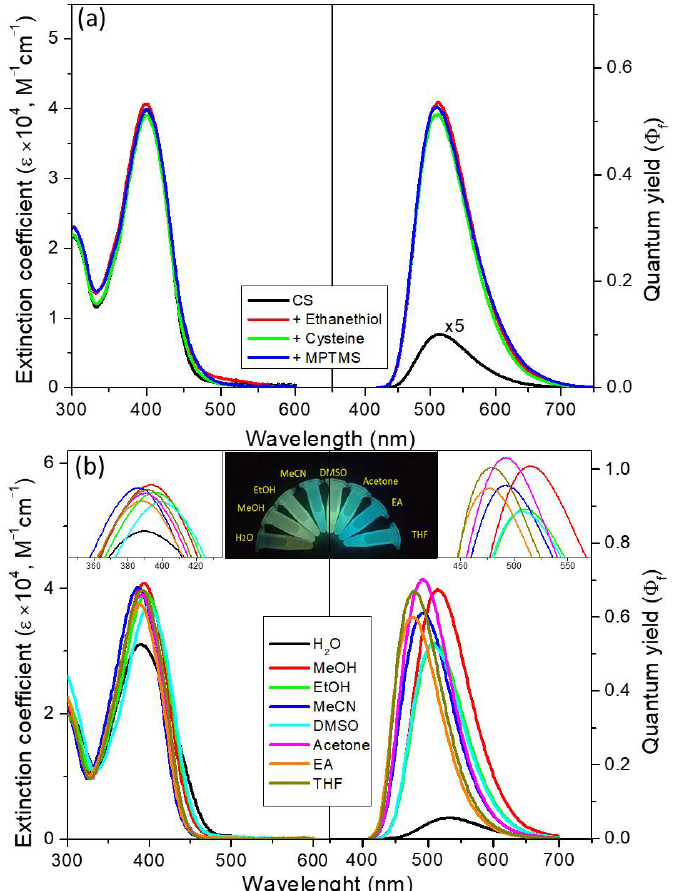
Figure 2. Absorbance (left) and emission (right) spectra represented by extinction coe ffi cient and quantum yield, respectively. ( a ) Thiol-induced CS in ethanol; ( b ) solvent e ff ect of compound CSP excited at the wavelengths of the absorption maxima. The insert spectra show the zoom in of tops of absorption / emission spectra, and the inset photos show the emission color changes of the probes (10 µ M) under a handheld ultraviolet lamp (365